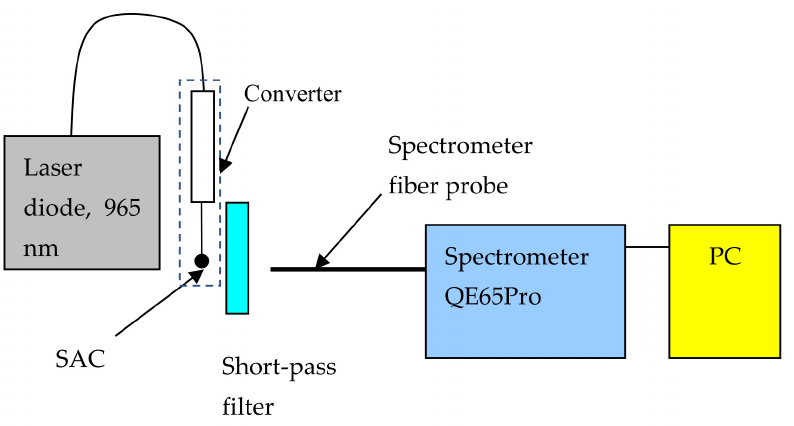
Figure 1. Schematic of the experimental setup for determining the temperature by the two-color method.